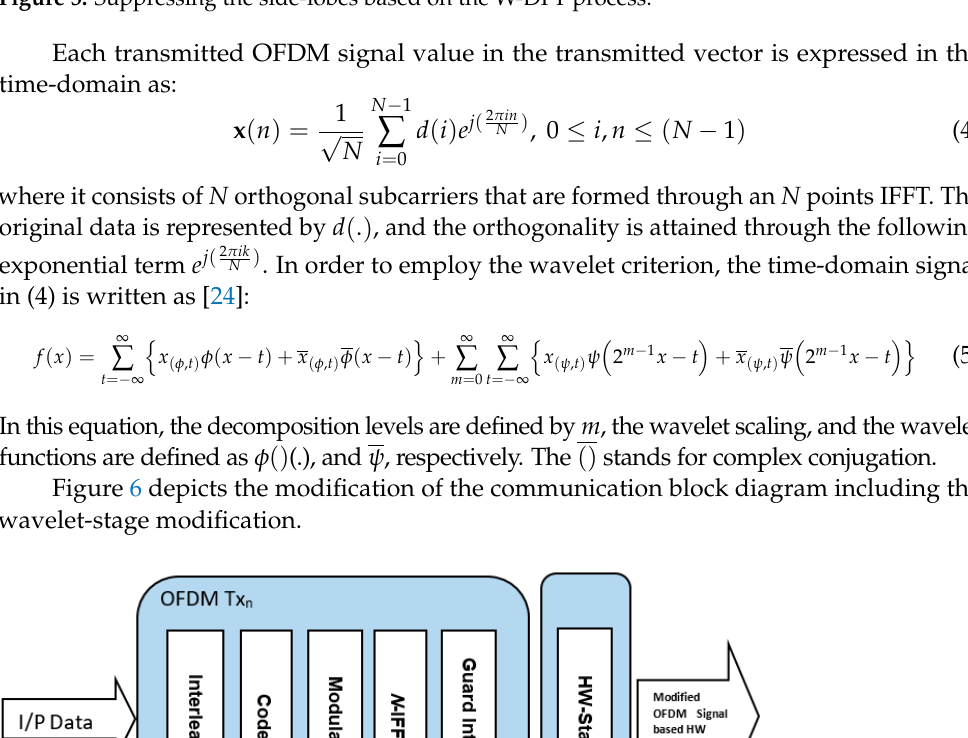
Figure 5. Suppressing the side-lobes based on the W-DFT process.